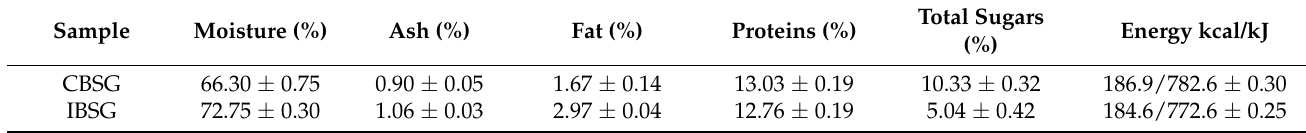
Chemical analysis of IBSG and CBSG (calorific value of dried CBSG and IBSG), mean ± standard deviation